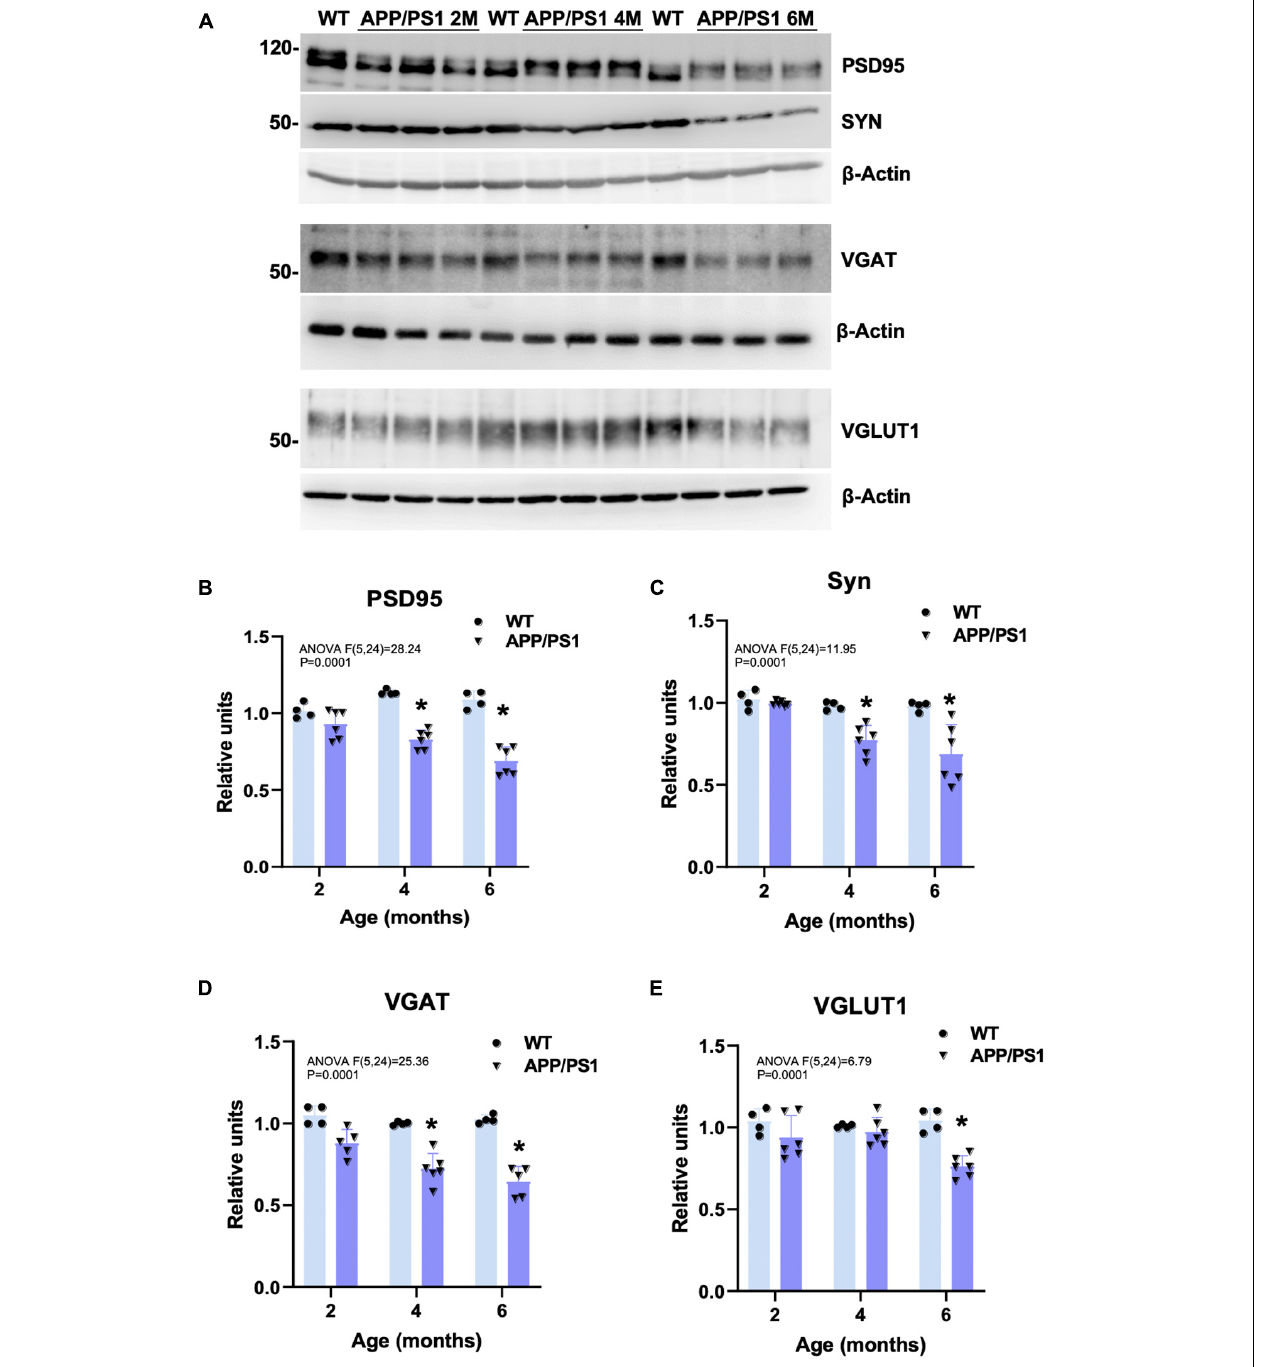
FIGURE 2 | Decreased hippocampal synaptic markers in young APP/PS1 mice. (A) Representative Western blots for several synaptic markers in 2-, 4-, and 6-month-old APP/PS1 ( n = 6/age) and WT ( n = 4/age) hippocampal samples. Quantitative analysis showed a significant and progressive decrease in the postsynaptic marker PSD95 (B) , and the presynaptic markers SYN (C) and VGAT (D) from 4 to 6 months of age in the double transgenic mice compared to age-matched WT. Moreover, levels of VGLUT1 were significantly reduced at 6 months of age (E) . Represented data were normalized respect to 2-month-old WT samples. Tukey’s test: * p <